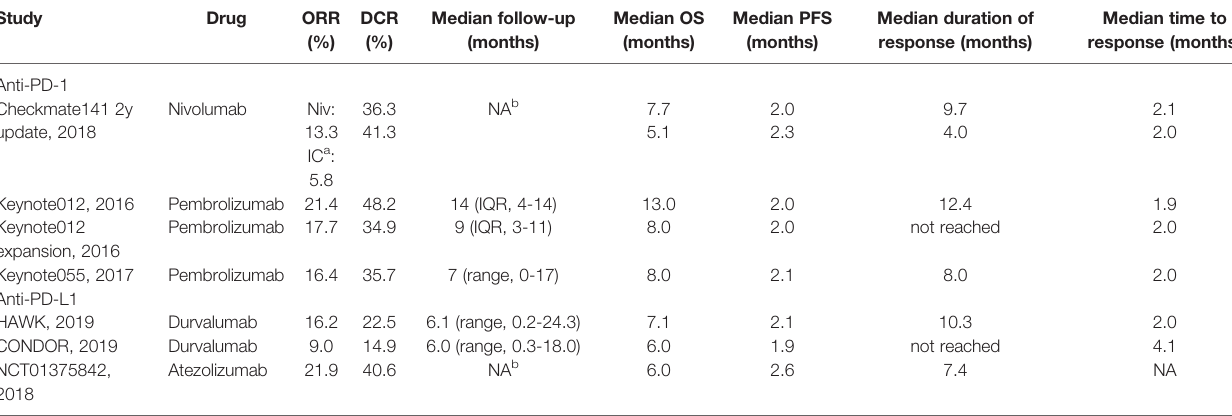
TABLE 2 | The response and survival time of included studies.